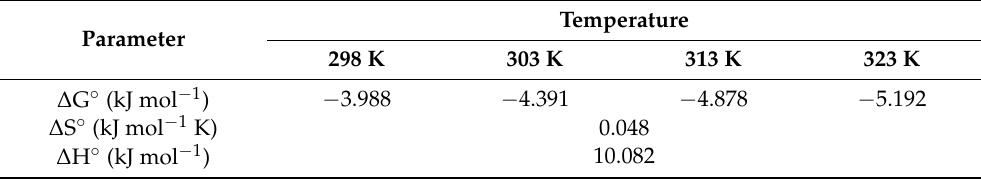
Table 7. Thermodynamic parameters of adsorption of basic-blue-41 using Zr(6)-PCH material.